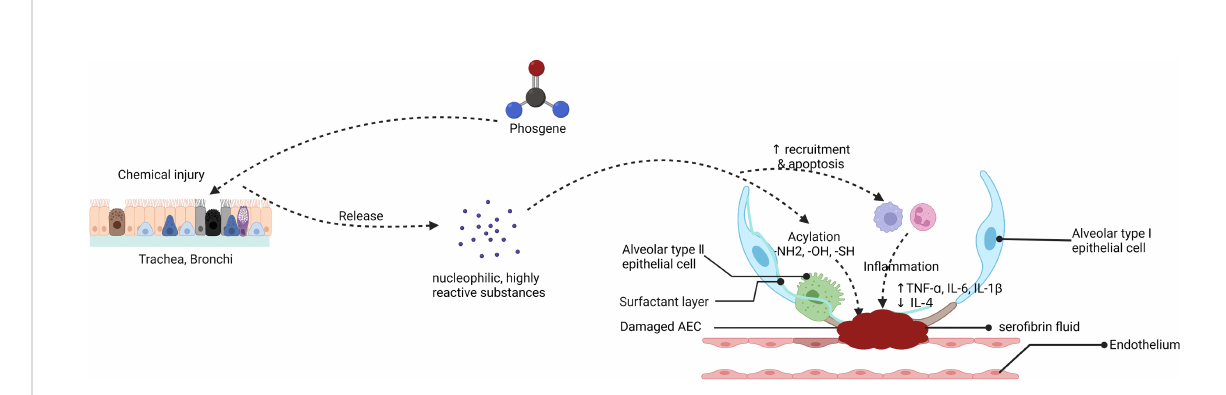
FIGURE 3 Putative mechanism of the endothelial-epithelial barrier damaged in phosgene-induced acute lung injury (created with